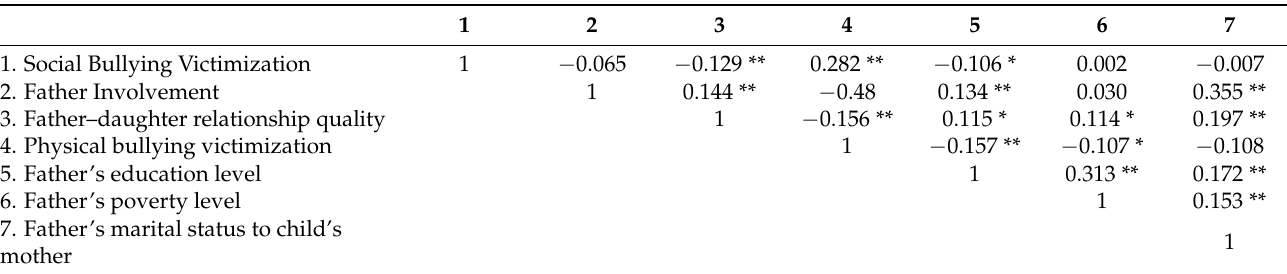
Table 2. Bivariate Correlation Analyses between all